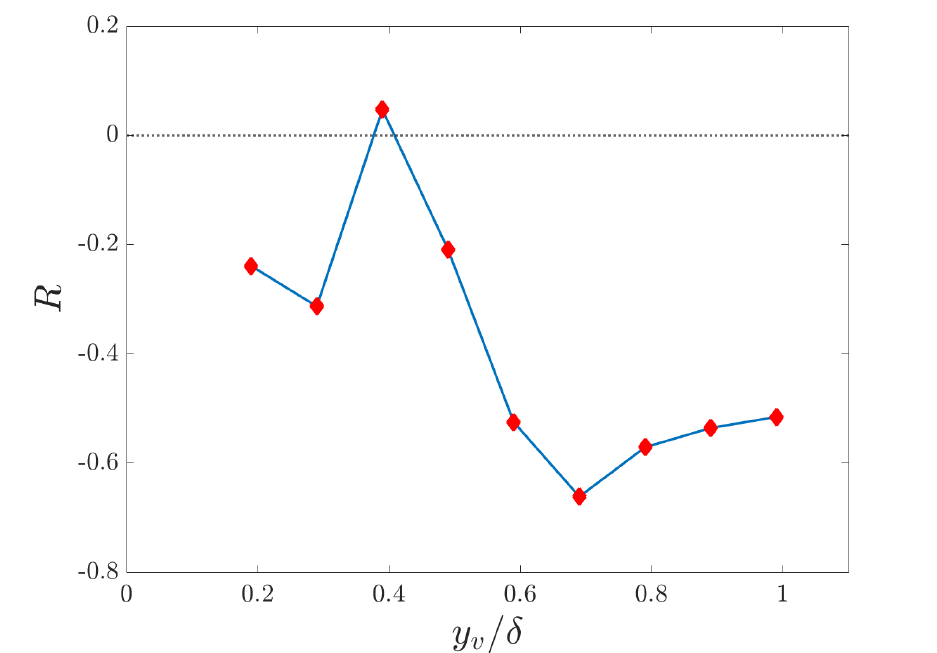
Figure 6. A plot of correlation coefficient, R , against normalised height of the vortex y v / δ . The red squares indicate the mean correlation at each binned